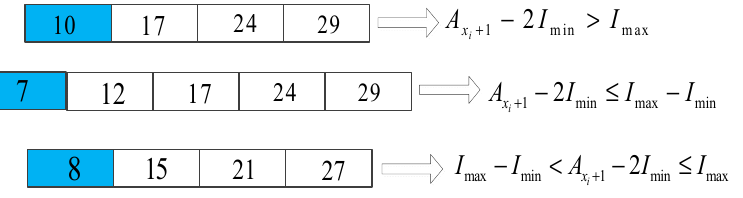
Figure 4. Illustration of the mutation operator for case 1.